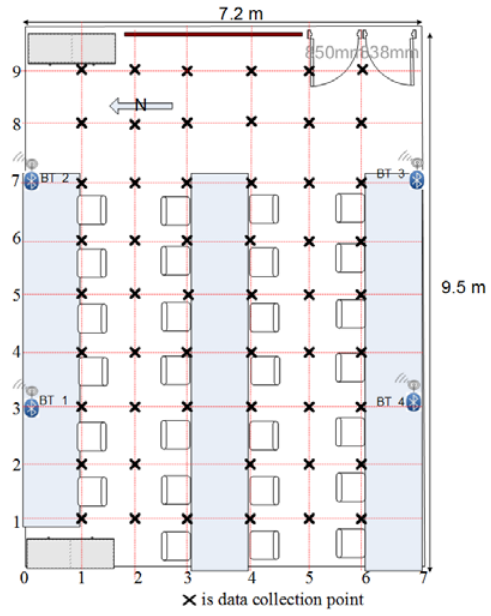
Figure 1. Setup of Bluetooth stations at Experimental site type I.